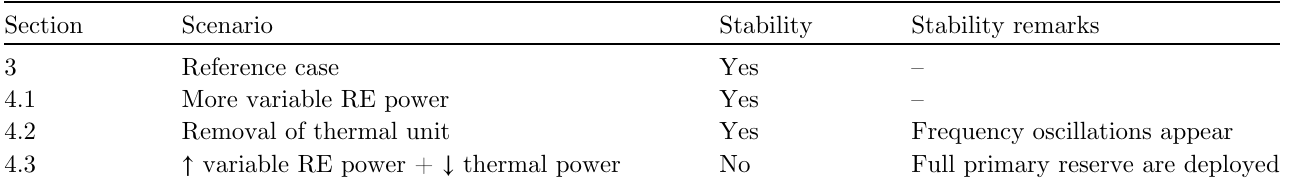
Table 5. Summary of the studied